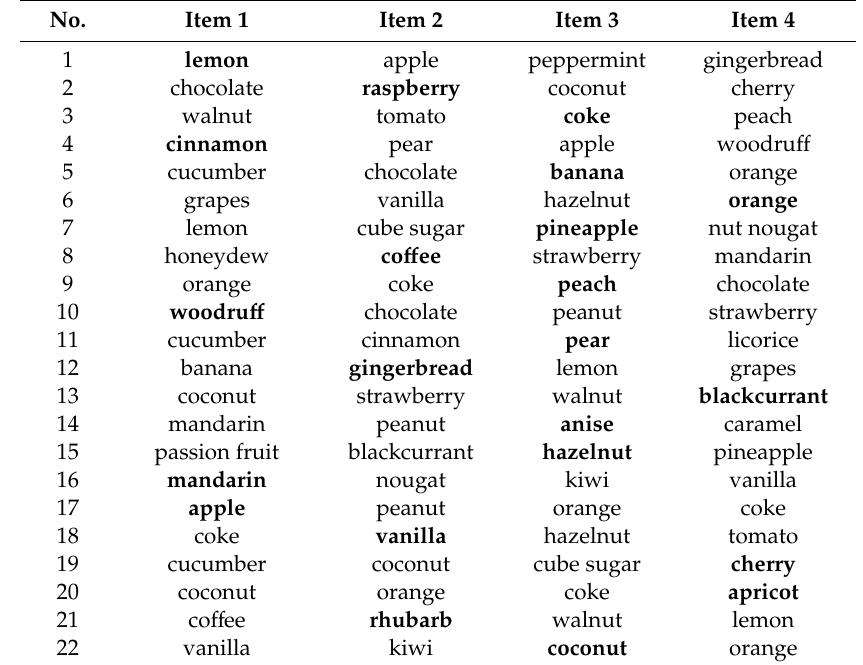
Table 1. The 27-item Candy Smell Test